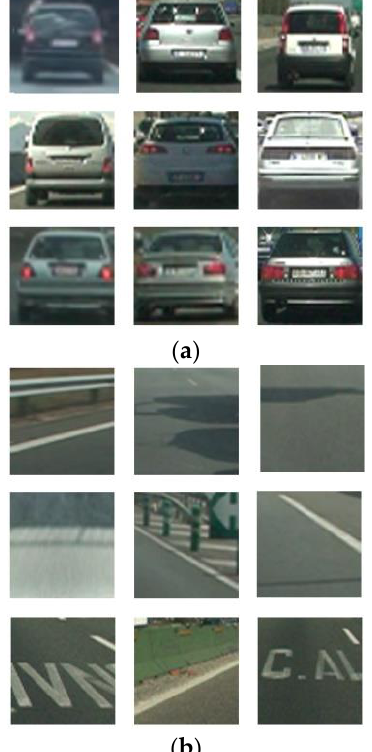
Figure 9. Typical ( a ) positive and ( b ) negative images from the GTI DATA vehicle image database 2012 [16].